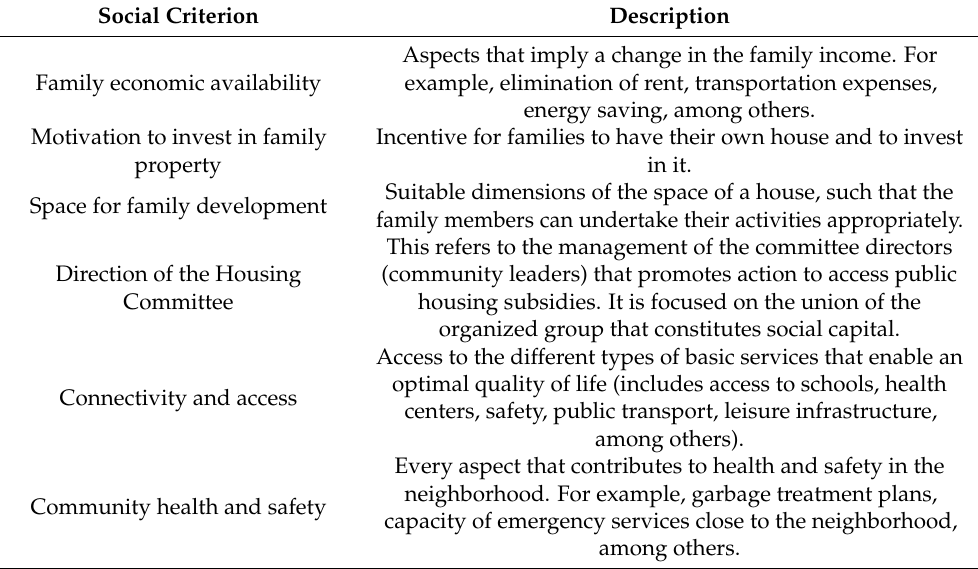
Table 1. Social criteria determined in the planning of public housing in Chile (Source: Adapted from